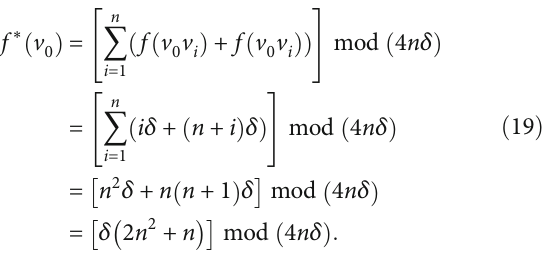
Figure 3: An alternate triangular cycle A ð C